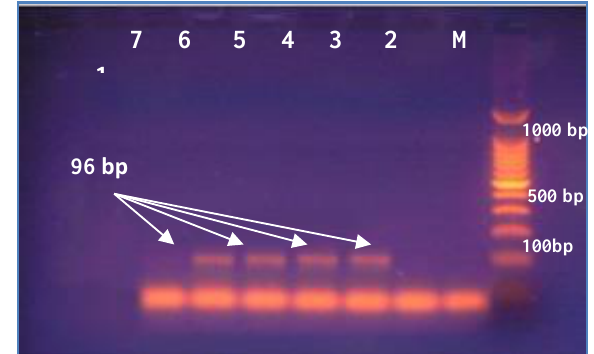
Figure, 2: Second run of n PCR (amplification of 96 bp fragment of B1 gene T. gondii DNA product from first round n PCR from blood sample of the infected women, sheep and control subjects.Lane-M is molecular marker (100bp). Lanes 1 Negative Control. Lanes 2 negative human samples at 96bp. Lanes 3, 4 are positive women(CM) and (MW) respectively. Lanes 5, 6, are positive sheep (CM) and (MW) respectively. Lanes 7 are negative sheep samples at 96bp. Running conditions: Agarose gel (1.5%), 5 volt/cm² for 2 hrs. stained with ethidium bromide.